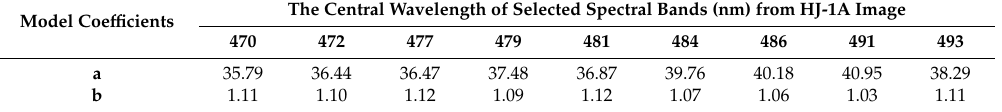
Figure 13. Spatial distributions of ( a ) soil moisture and soil heavy metal contents in the validation area: ( b ) As; ( c ) Cd; and ( d ) Hg (note: health standards are 30 mg/kg for As and 0.3 mg/kg for Cd and Hg). Table 4. The values of parameters a and b for the spectral ratio (SR) model of DSSR to MSSR with SR = a × e bx